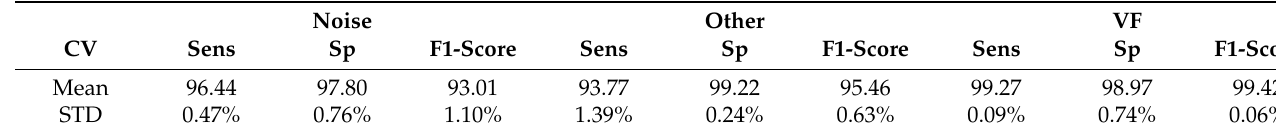
Table 9. Performance of the first stage cross-validation test using the AUC of the ROC curve. Table 8. First stage Sens, Sp, and F1-score for the 5-fold cross-validation.